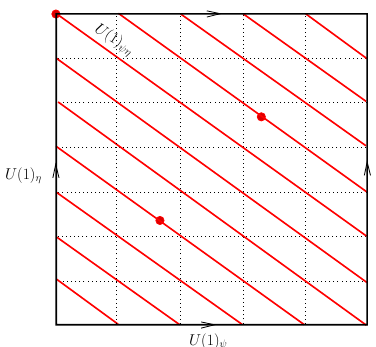
Figure 1 . The torus U(1) (cid:2) U(1) (cid:17) for N = 3. The edges are identi(cid:12)ed as the arrows show, the corners represent the identity of the group. The unbroken subgroup U(1) (cid:17) (red line) passing through all the points of the lattice ( Z 5 ) (cid:2) ( Z 7 ) (cid:17) . The dots indicate the elements of the center of the gauge group Z 3